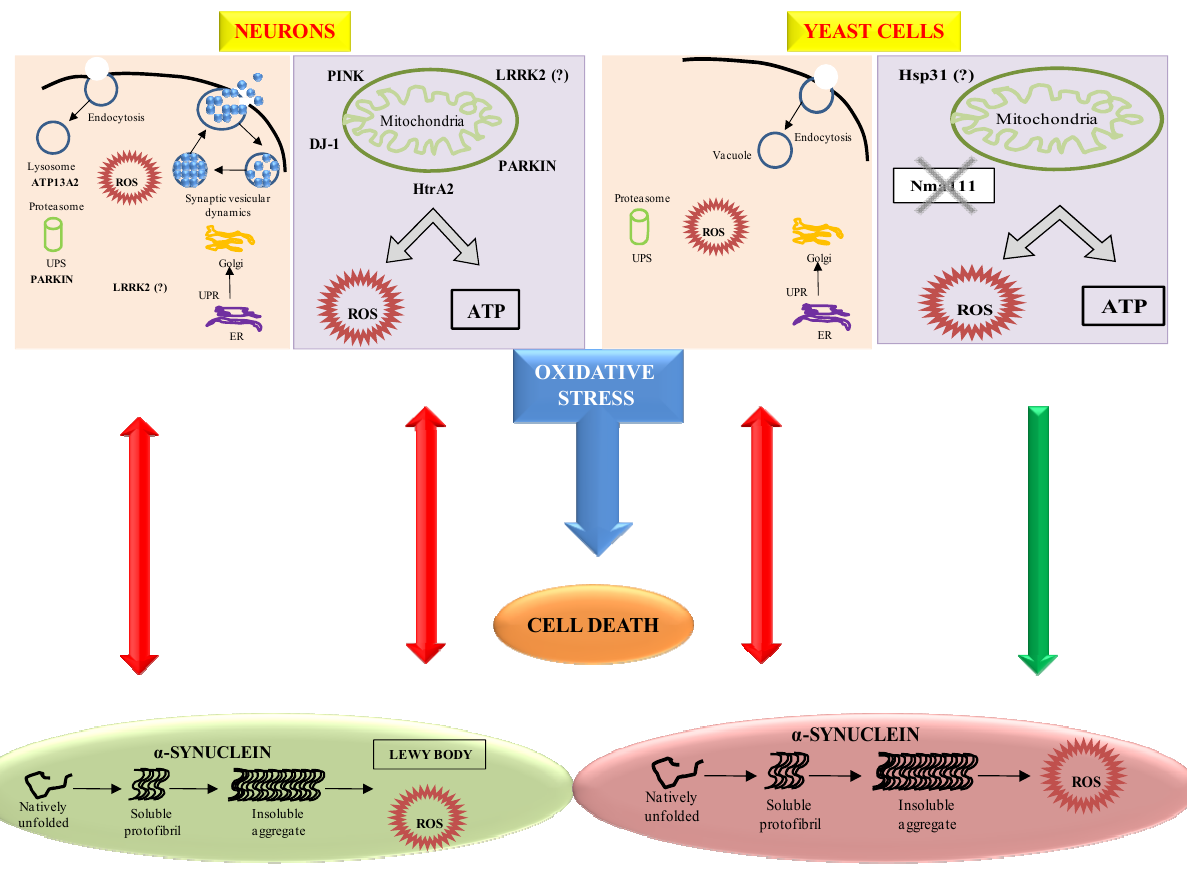
Figure 3. Molecular mechanisms leading to cell death in neurons and the yeast PD model (Adapted from: Winderickx et al.